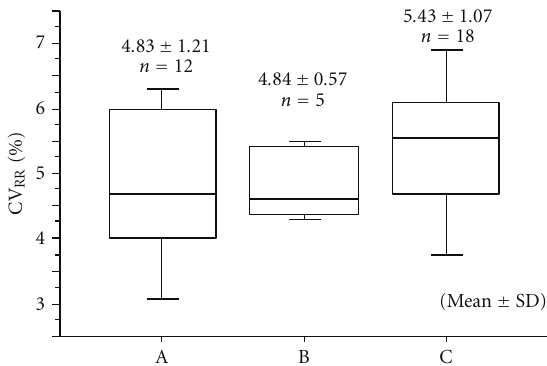
Figure 5: Intergroup changes in the coe ffi cient of variance (CV RR ) during normal pregnancy. Group (A): 28–31 weeks of pregnancy; Group (B): 32–35 weeks of pregnancy; Group (C): 36–40 weeks of pregnancy. One-way ANOVA: P = 0 . 28 [17].